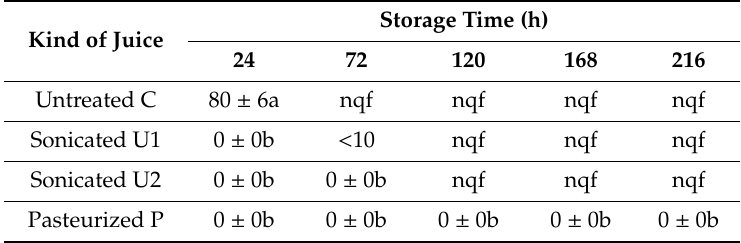
Table 4. Total number of mesophilic microorganisms (cfu / mL) in apple juice from piston press after ultrasound treatment stored at 20 ◦ C. Di ff erent letters in the same column indicate values significantly di ff erent at P < 0.05.